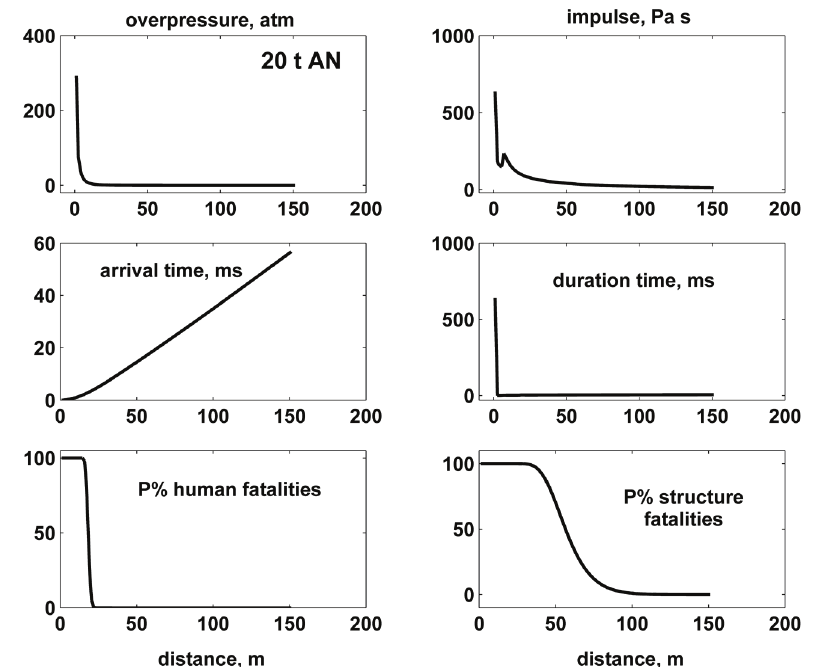
Fig. 2 – The blast parameters [p0, ip, td, ta], and the P% fatalities for humans and structures at various distances from the explosion centre (case of 20 t AN explosion)